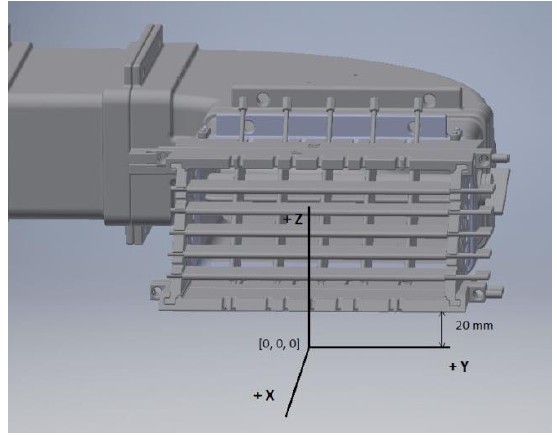
Fig. 2. Detail of measured air vent [10]